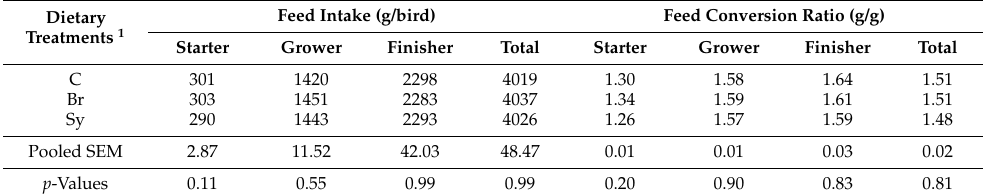
Table 2. Effect of dietary treatments on the feed intake and feed conversion ratio of broiler chickens. Dietary Treatments